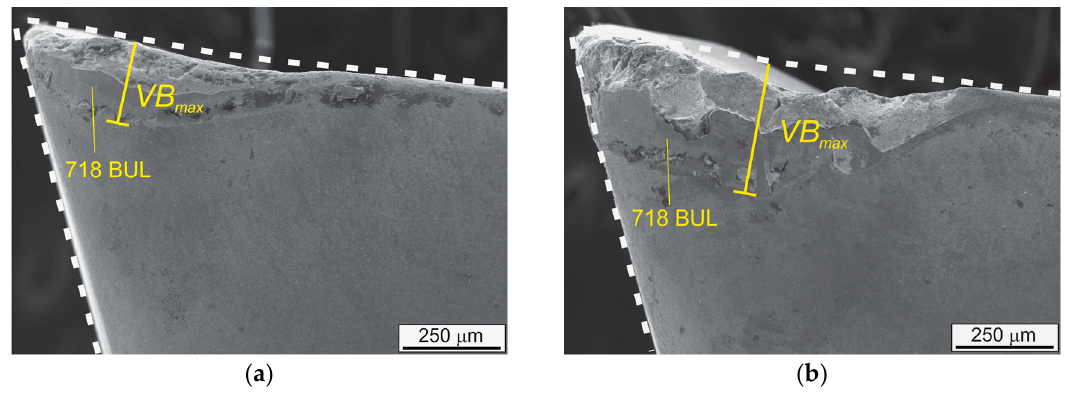
Figure 5. Scanning electron microscope (SEM) images of Tool dry2 side flank face with zero pass edge outline (ZPEO): ( a ) after the third pass, and ( b ) after the fourth pass.